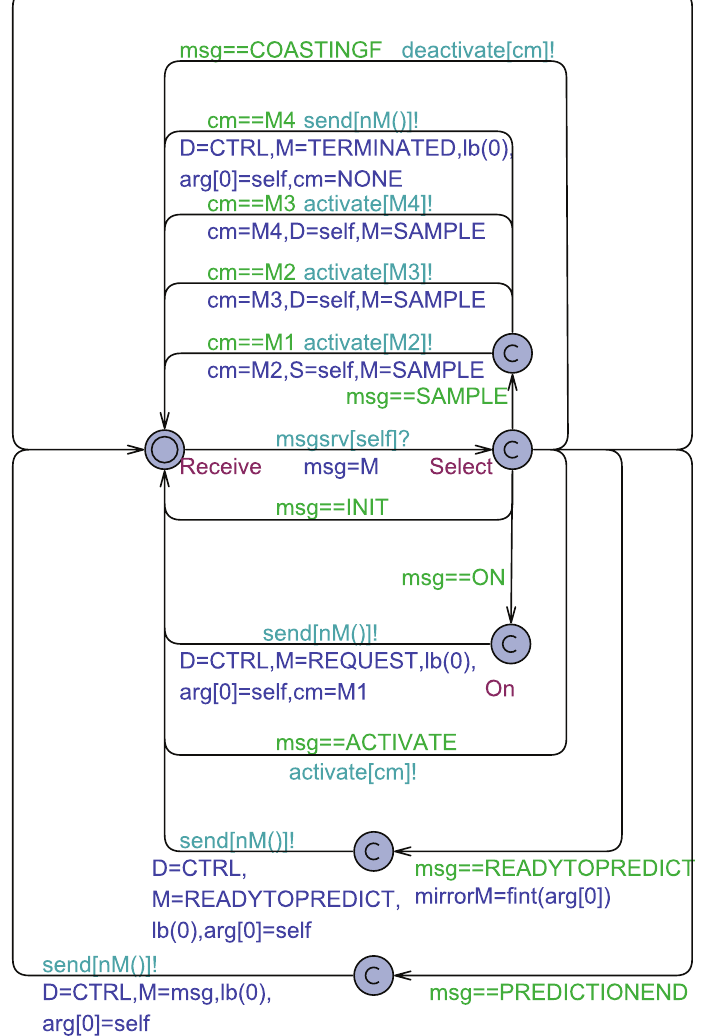
Figure 7. The HVAC actor